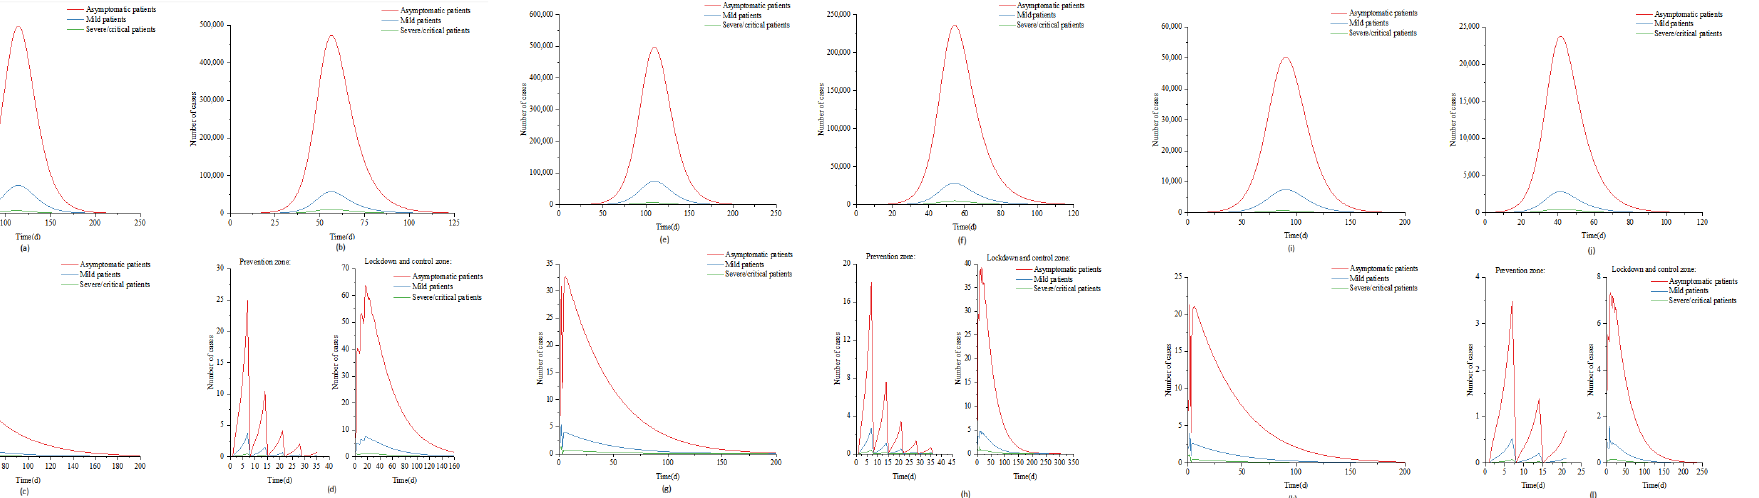
Figure 2. Epidemic development under scenarios 1–4 of cities of different scales. Panels ( a – d ) correspond to the change in the number of asymptomatic infected persons, mild patients, and severe/critical patients under the big city scenarios 1–4; panels ( e – h ) correspond to the asymptomatic infections under the medium city scenarios 1–4, the number of mild patients, and the number of severe/critical patients over time; panels ( i – l ) corresponds to the change in the number of asymptomatic infections, mild patients, and severe/critical patients in small city scenarios 1–4.